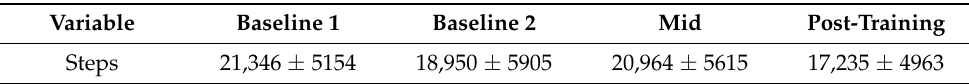
Table 4. Habitual physical activity recorded over a 48 h period in inactive women performing low-volume HIIT (mean ±